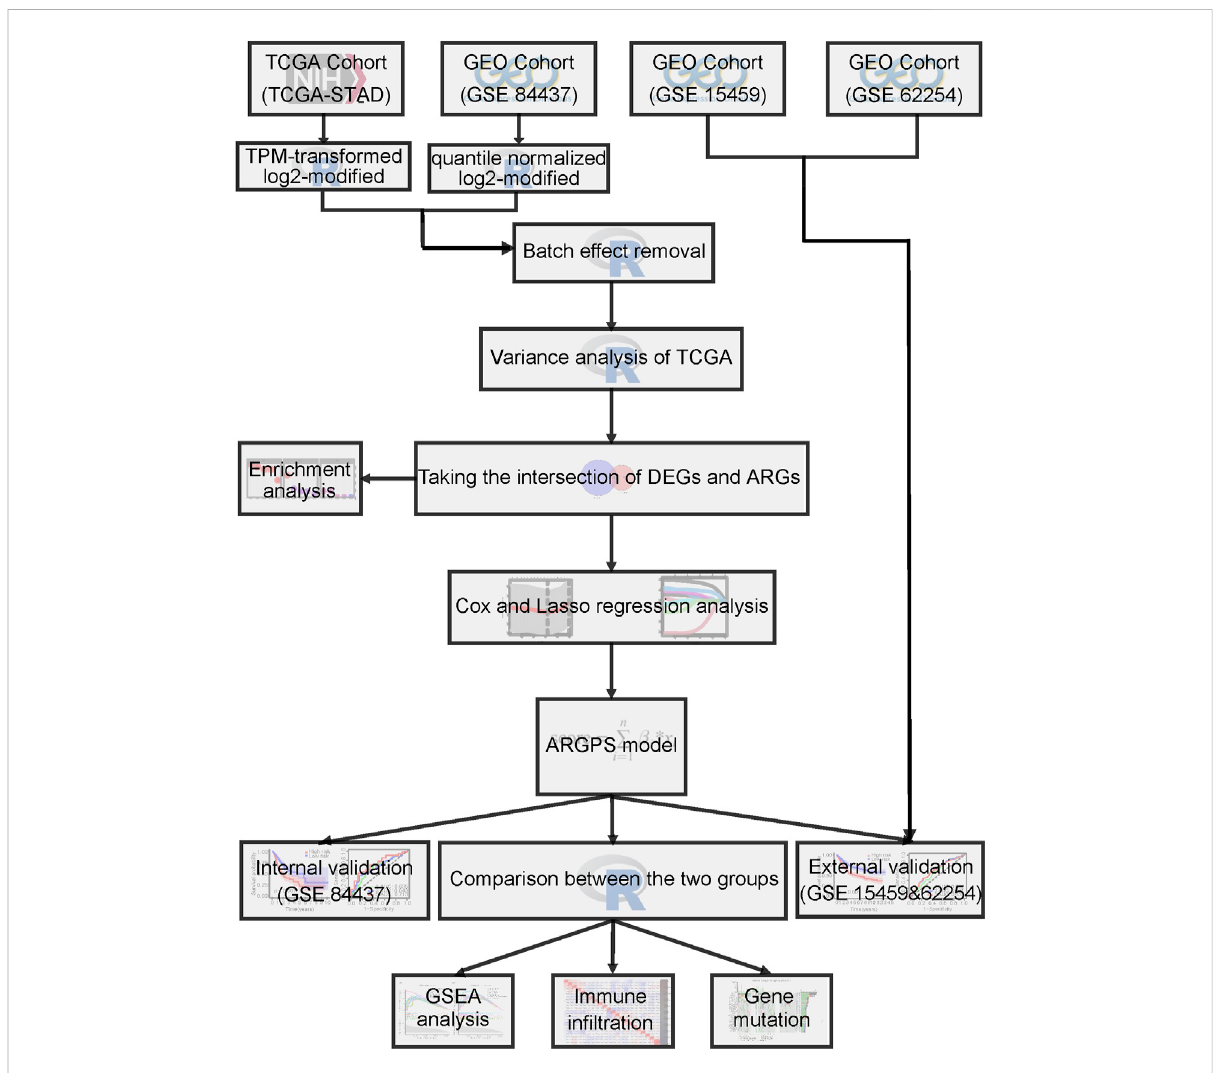
FIGURE 1 Drawing of the fl ow chart in this